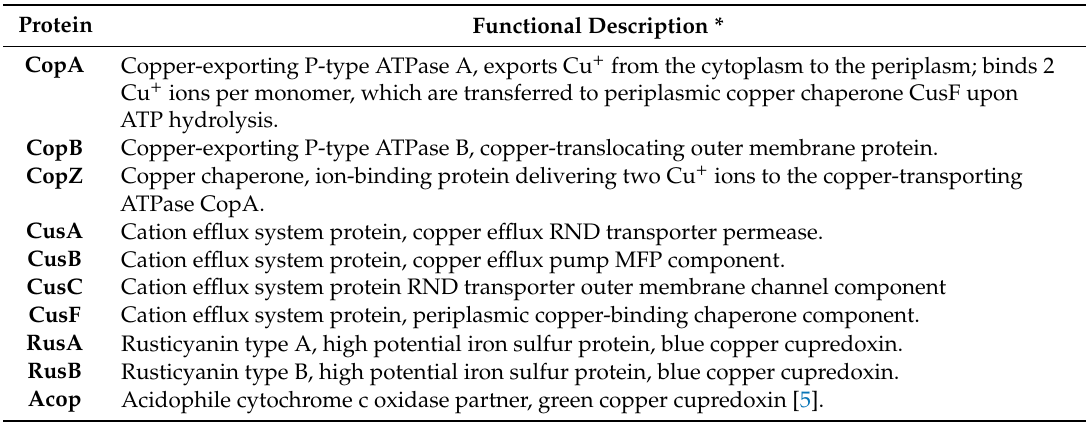
Table 1. Interest copper resistance markers from Acidithiobacillus. MFP, membrane fusion protein. Protein Functional Description